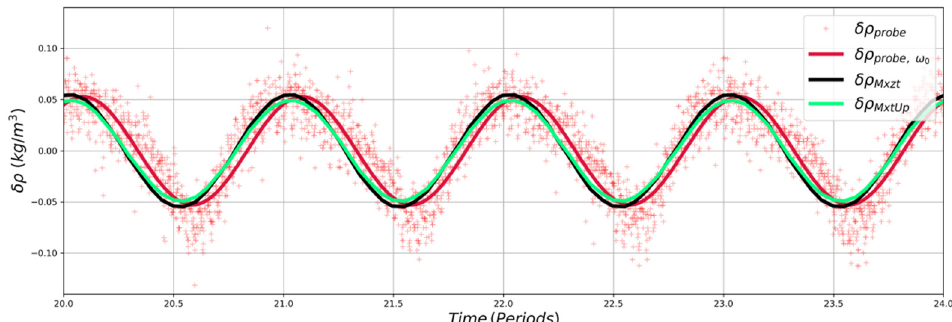
Figure 9. Density measurement filtered at the fundamental frequency ω 0 (red curve) and estimation (black and green curves) of the density anomaly from synthetic Schlieren using our two methods. Measurements are taken at a location (black square on Figure 7) in the middle of an upward propagating ray. The red crosses represent the raw probe data.